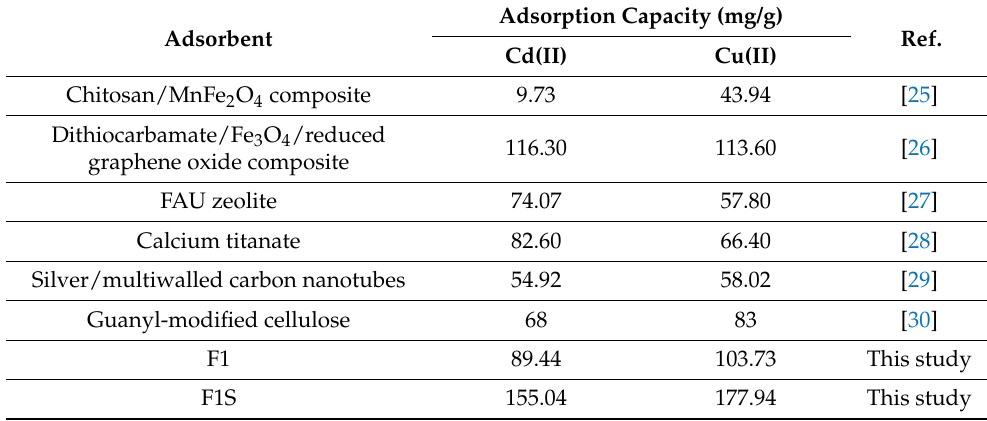
Table 6. Comparison between the uptake capacity of the synthesized samples (F1 and F1S) and that of other